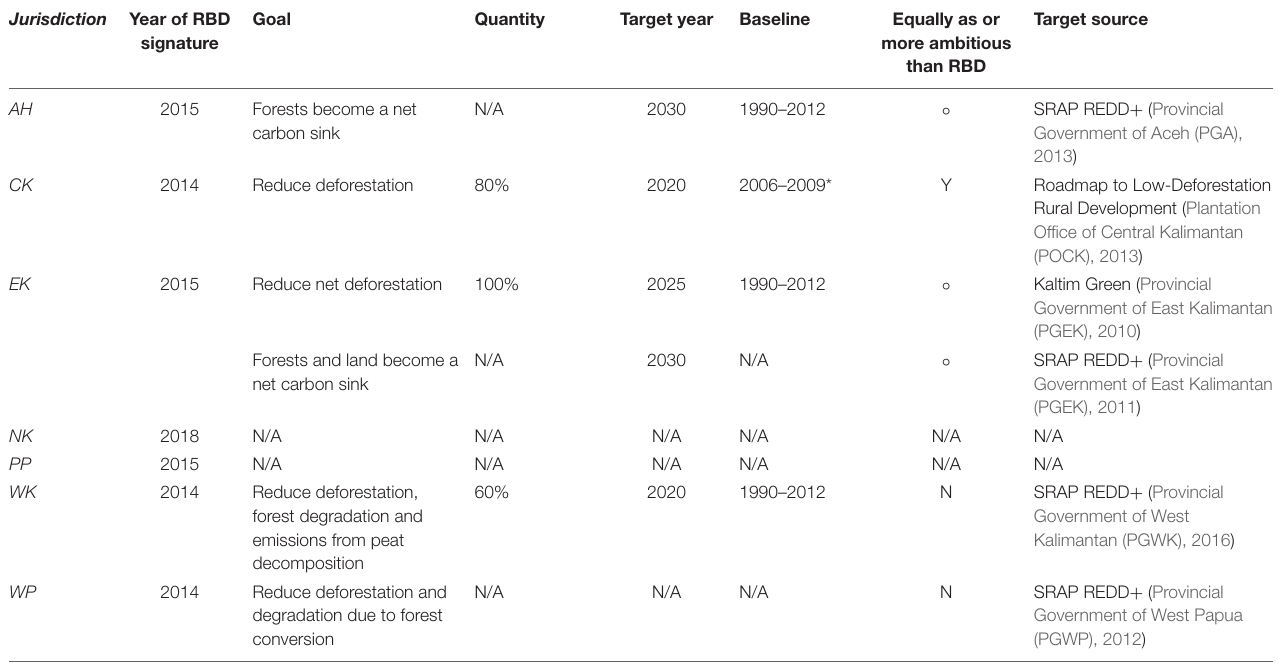
TABLE 3 | Inventory of deforestation targets (“legal targets”) of the seven GCF TF member jurisdictions located in Indonesia.